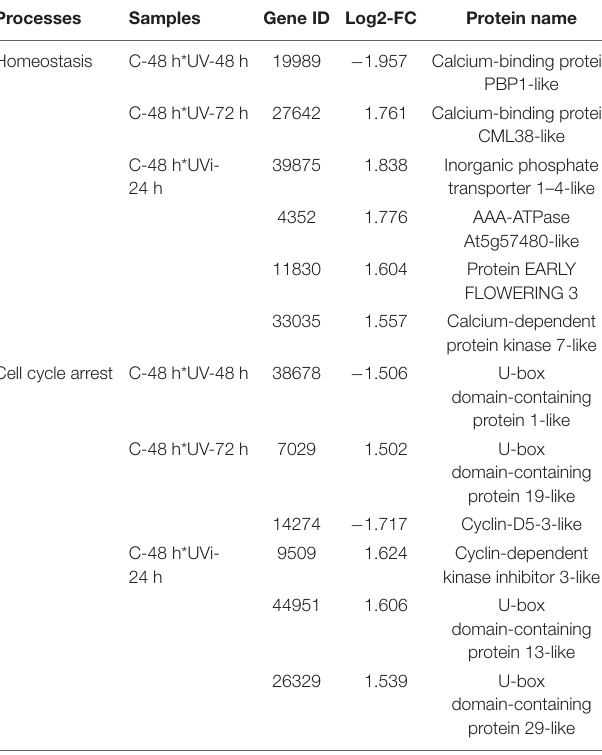
TABLE 4 | Relative expression of cell morphology and growth genes. Processes